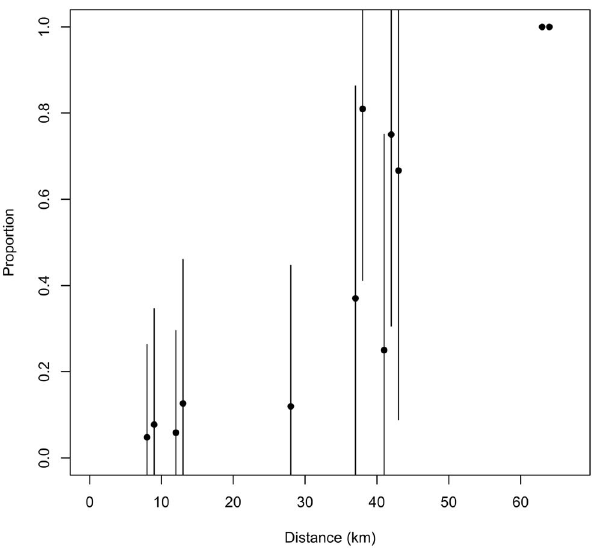
Figure 4. Use of landfills and transhipment sites by Ring-billed gulls. Mean ( 6 1 SD) proportion of Ring-billed gull locations at landfills and transhipment sites in foraging patches within 1-km concentric bands located at different distances from the colony. All landfills and open transhipment sites were visited by at least one tagged individual. Some sites encompassed more than one band.